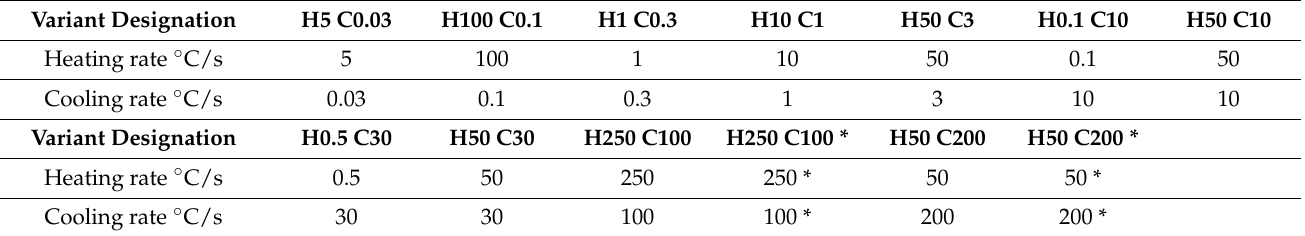
Table 3. Heating and cooling rate variants in the dilatometric tests.